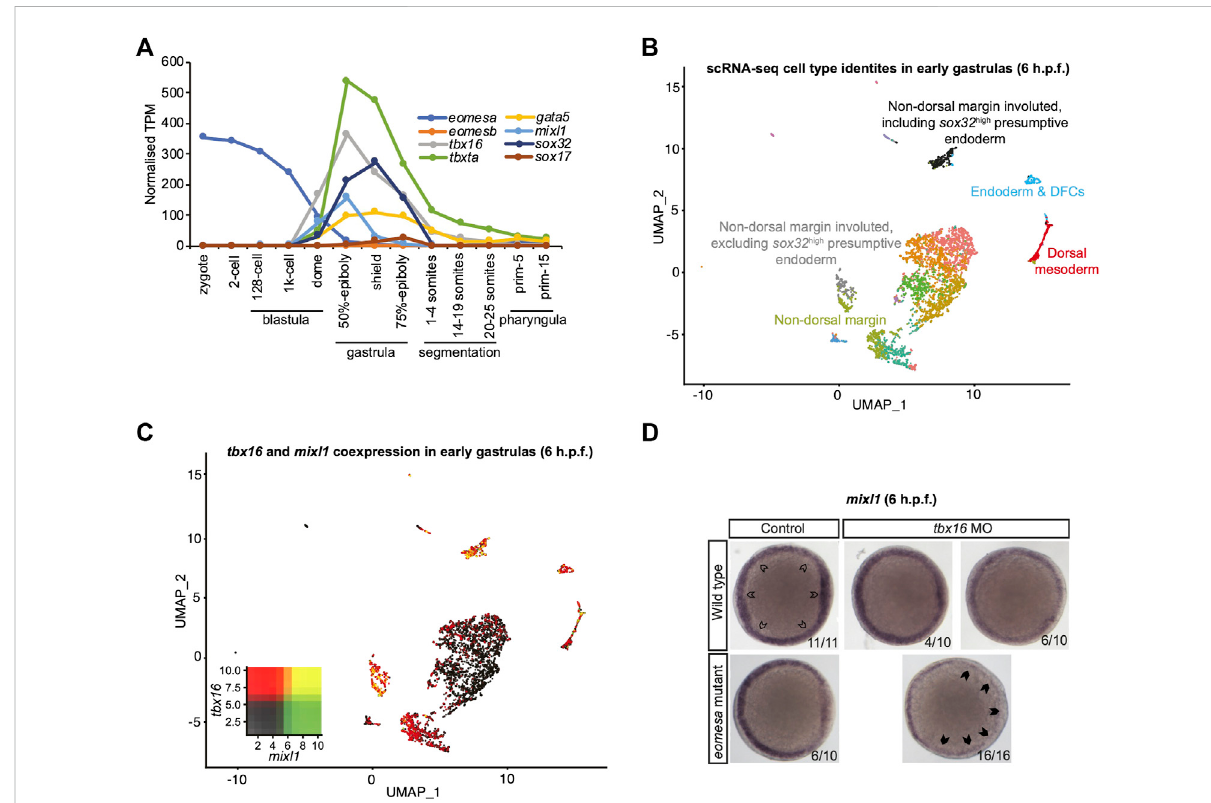
FIGURE 3 Eomesa and Tbx16 are redundantly required for mixl1 expression in the presumptive endoderm. (A) Timing of expression of T-box factors ( eomesa , eomesb , tbxta , tbx16 ) under study and presumptive endoderm ( mixl1 , gata5 , sox32 ) and endoderm markers ( gata5 , sox32 , sox17 )indicated by bulk RNA-seq data from (White et al., 2017). Gene expression is shown as transcripts per million (TPM). Stages are as de fi ned by (Kimmel et al., 1995). (B) UMAP clustering analysis of single-cell RNA-seq data for early gastrulas (6 h.p.f.) zebra fi sh embryos (Wagner et al., 2018) indicating colour-coded cell type identities. Cell types relevant to the present study are labelled. The identities of all cell types are indicated in Supplementary Figure S3. (C) UMAP clustering analysis of single-cell RNA-seq data for early gastrulas (6 h.p.f.) zebra fi sh embryos indicating co-expression